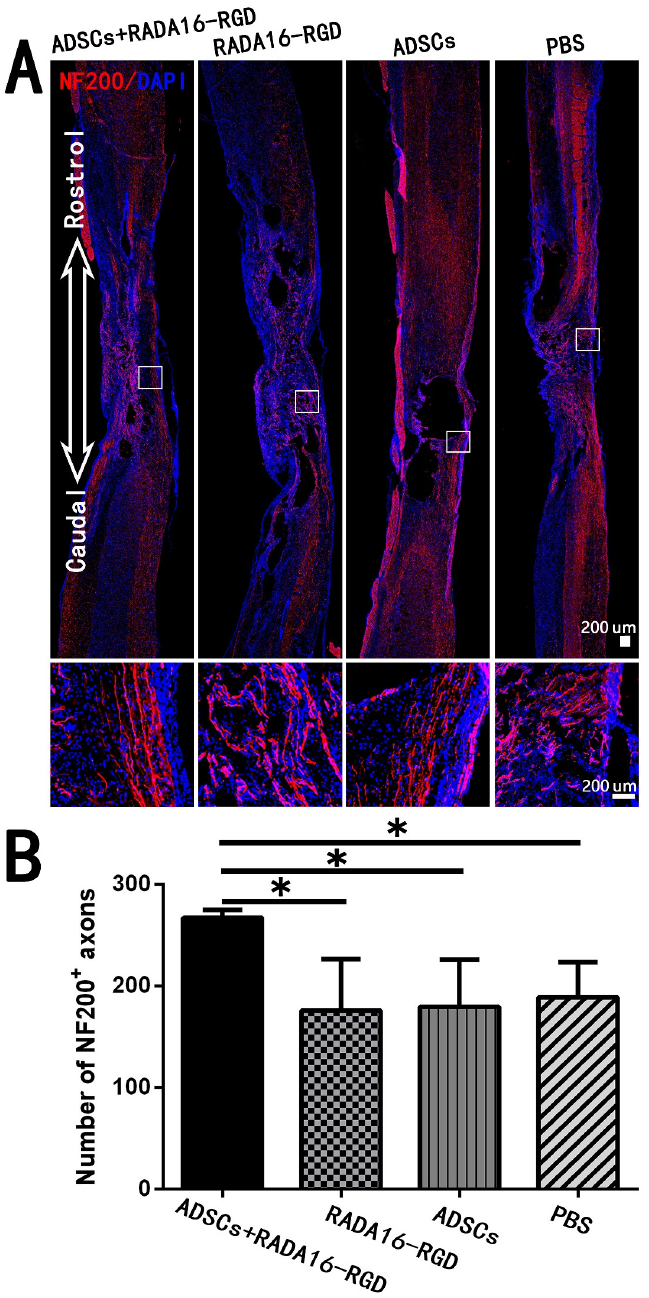
Figure 6. ADSCs+RADA16-RGD transplantation increases the number of NF200 + nerve fibers at the injury center. ( A ) At 8 weeks of transplantation of ADSCs+RADA16-RGD, NF200 antibody staining (red) was performed via passing through the central sagittal section of the spinal cord injury. The panels below ( A ) show high magnification of boxed regions in the top panels. ( B ) Quantitative analysis of NF200 + nerve fibers at the injury center. The ADSCs+RADA16-RGD group was significantly higher than the PBS, ADSCs, and RADA16-RGD groups (ADSCs+RADA16-RGD vs. PBS, ADSCs, or RADA16-RGD: p < 0.05). * p < 0.05. Data are presented as mean ± SEM ( n = 3 per group). Scale bar = 200 µ m. ADSCs: adipose stem cells; NF200: neurofilament 200; DAPI: 4 (cid:48) 6-diamidino-2- phenylindole. NF200 (red): Alexa Fluor 647. The number of 5-HT + fibers in the injury center was significantly higher in the ADSCs+RADA16-RGD (Figure